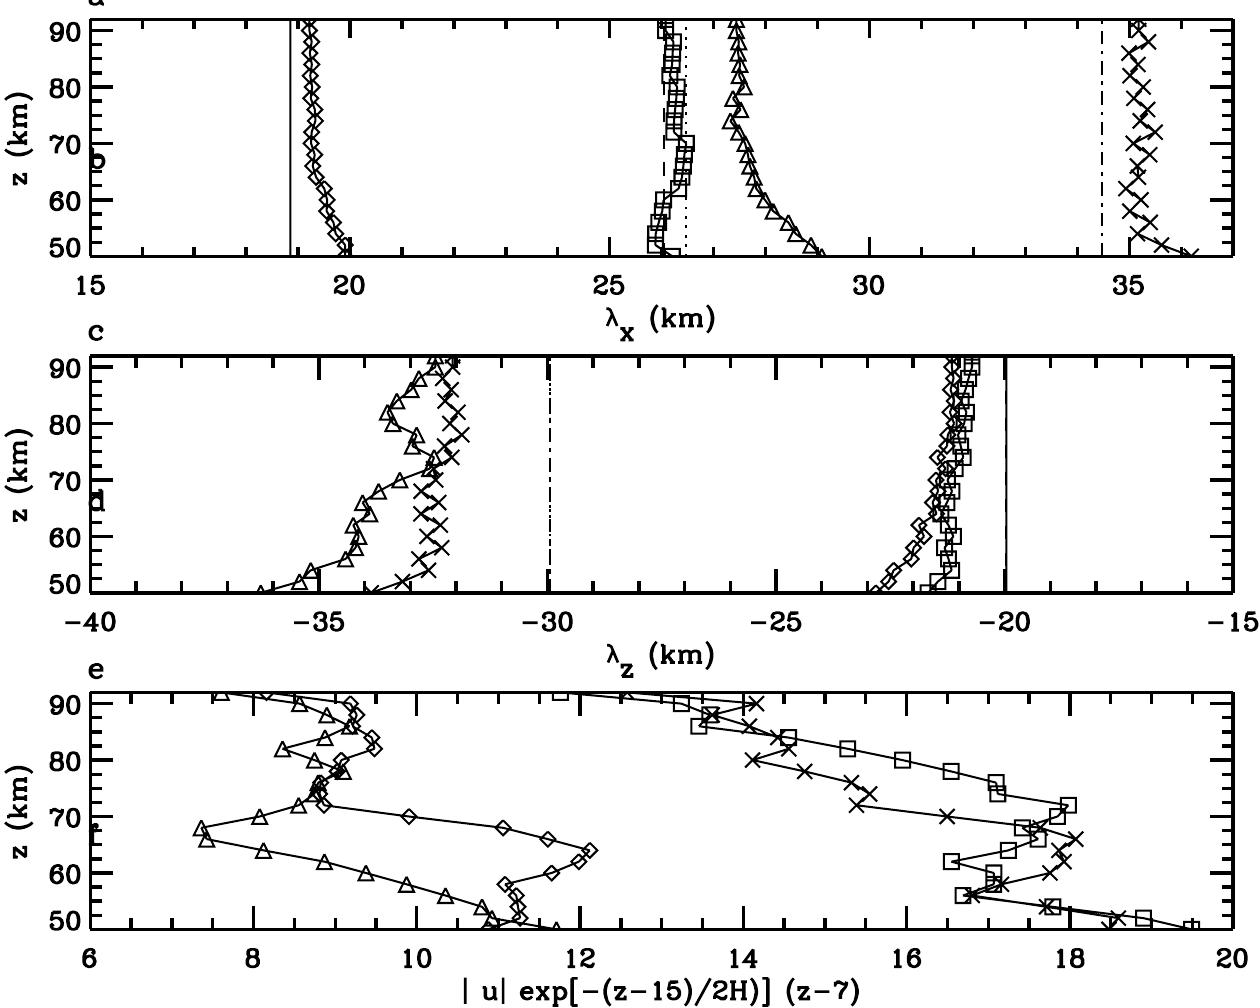
Fig. 15. (a–b) Same as in Fig. 14a–b, but for the GWs in Table 3. (c) Values of | u | (z − z 0 ) exp ( − (z − z trop )/ 2H ) for the ray trace bins closest to the individual GWs in a-b. Symbols are the same as in